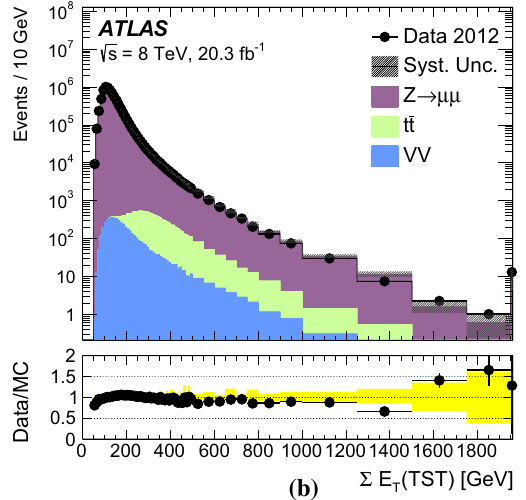
Fig. 5 Distributions of a (cid:5) E T (CST) and b (cid:5) E T (TST) are shown in data and MC simulation events satisfying the Z → μμ selection. The lower panel of the figures show the ratio of data to MC simulation, and